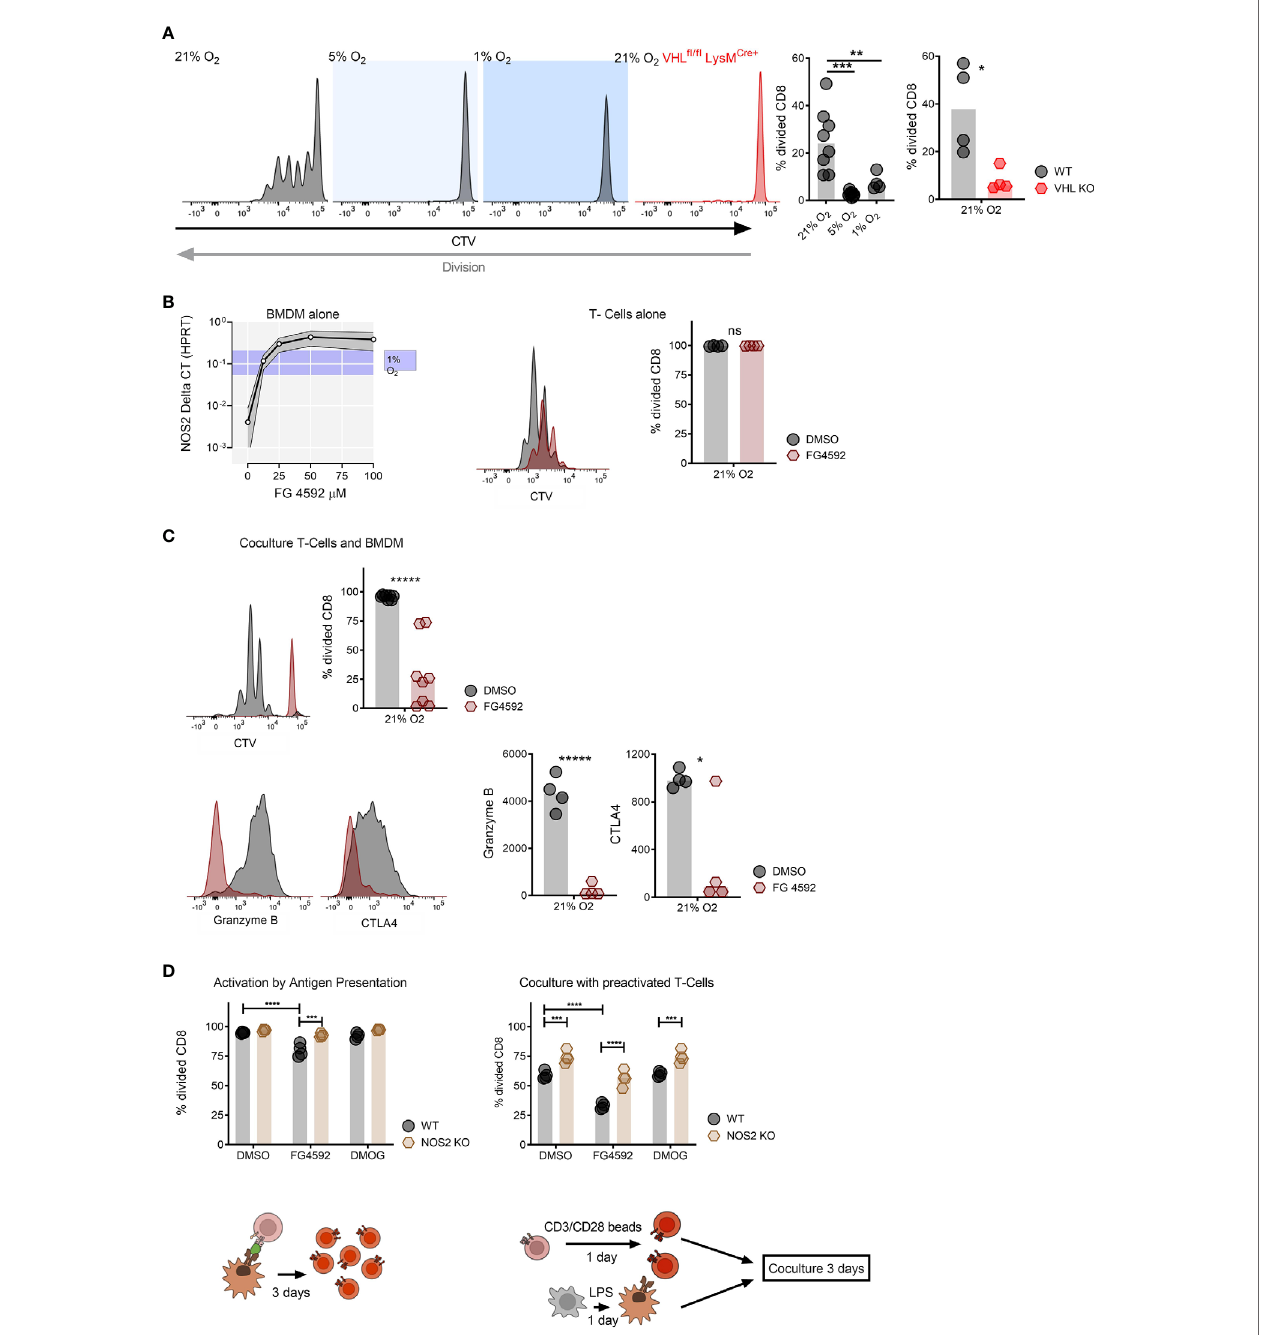
FIGURE 2 | Genetically and compound induced myeloid hypoxia blocks CD8 + T-cell division in vitro . (A) Representative fl ow cytometry histograms of CTV stained CD8 + T-cells co-cultured with OVA presenting BMDMs in 21%, 5%, 1% oxygen and with BMDMs without Von Hippel-Lindau (VHL fl / fl LysM Cre+ ) in 21% oxygen, division fraction of CD8 + T-cells co-cultured with antigen presenting wildtype BMDMs in different oxygen levels and division fraction of CD8 + T-cells co-cultured with VHL fl / fl (WT) vs VHL fl / fl LysM Cre+ (VHL KO) BMDMs in 21% oxygen. (B) NOS2 mRNA expression in BMDMs cultured with increasing concentration of FG-4592 (HIF prolyl-hydroxylase inhibitor) or hypoxia (with ranging values demonstrated as blue shade on y axis) and CD8 + T-cells in a single culture with DMSO or 12.5 µM FG- 4592. (C) Antigen presenting assay; BMDM and CD8 + T-cell co-culture treated either with FG-4592 compared to DMSO controls and expression of Granzyme B in CD8 + T-cells in co-culture with BMDMs. (D) Antigen presentation assay performed with NOS2 fl / fl or NOS2 fl / fl LysM Cre+ BMDMs in 21% treated with 12.5 µM FG- 4592 or DMOG and co-culture of pre-activated BMDM from NOS2 fl / fl or NOS2 fl / fl LysM Cre+ mice and pre-activated CD8 + T-cells from wildtype mice. Co-cultures were performed in media containing DMSO, 12.5 µM FG-4592 or DMOG. Data presented as scatter dot plots, *P < 0.05, **P < 0.01, ***P < 0.001, ****P < 0.0001, *****P < 0.00001; ns, not signi fi cant. Statistical analysis was performed with unpaired T test, n= 4-8 bone marrow